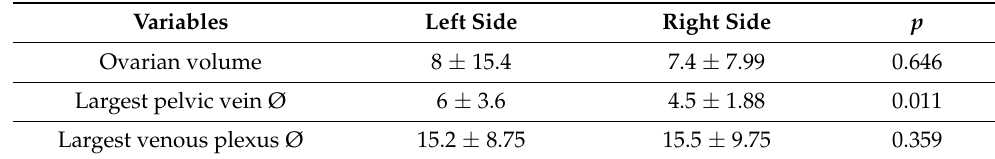
Table 3. Evaluation of differences based on laterality.